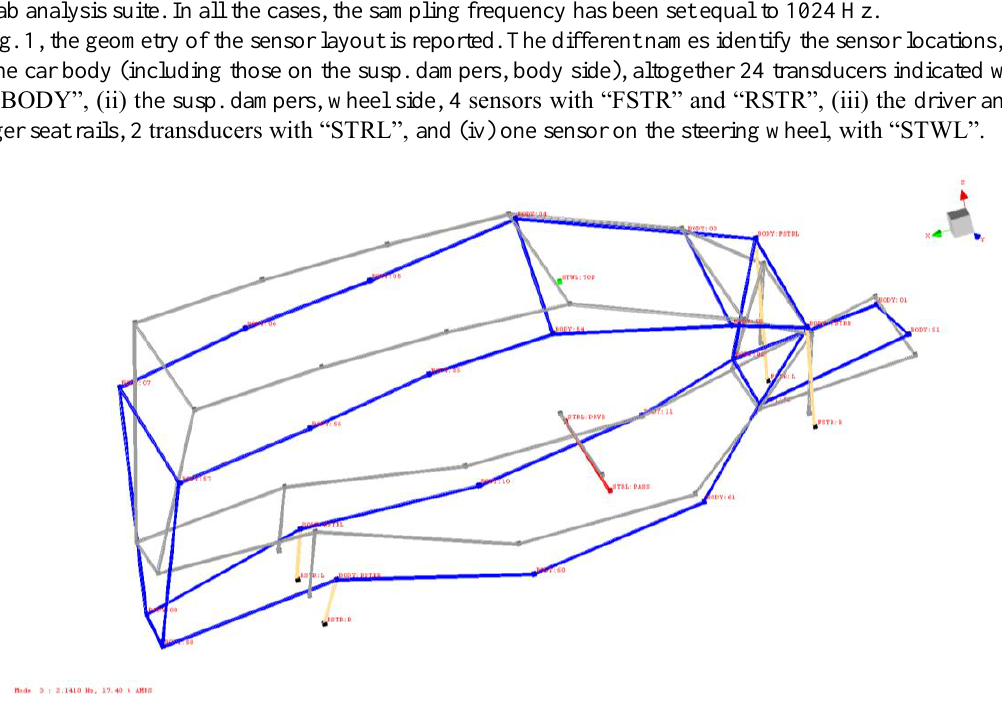
Fig. 1. The car pitch mode: The undeformed model is represented in grey. The set-up geometry with the used 31 sensor locations is highlighted with different names on the deformed model: 24 sensors on the car body, including 4 on the susp. dampers, body side, 4 on the susp. dampers, wheel side, 2 on the rails of the two front seats, 1 on the steering